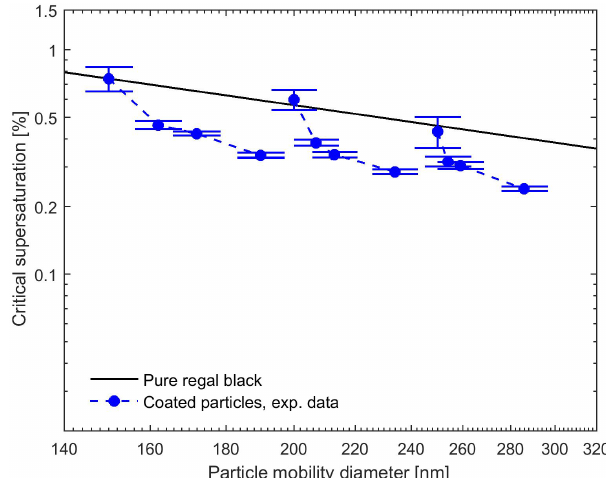
Figure 7. Experimental and theoretical critical supersaturations for coated BC by oleic acid for different particle mobility diameters. Black line represents the calculated critical supersaturations of the pure BC particles using FHH adsorption activation theory (Eq. 10). No CCN activation was observed for pure oleic acid